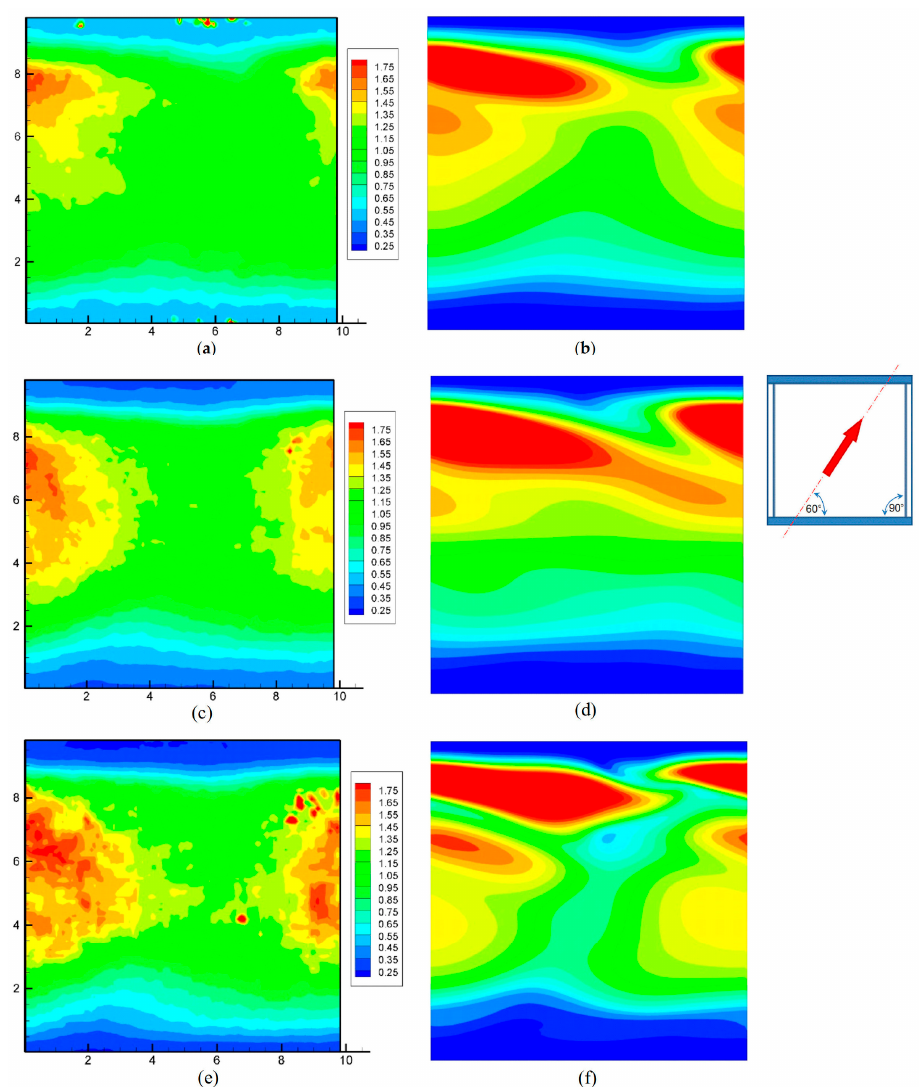
Figure 7. Configuration 2: distributions of the normalized heat transfer coefficient for increasing flow rates. ( a , b ) Q = 1 L / min. Re ≈ 205; ( c , d ) Q = 2 L / min. Re ≈ 410; ( e , f ) Q = 4 L / min. Re ≈ 820. Left column ( a , c , e ) experimental results; right column ( b , d , f ) CFD predictions. Coordinates are in mm. In this case only a partial agreement between simulation and experiments could be registered.